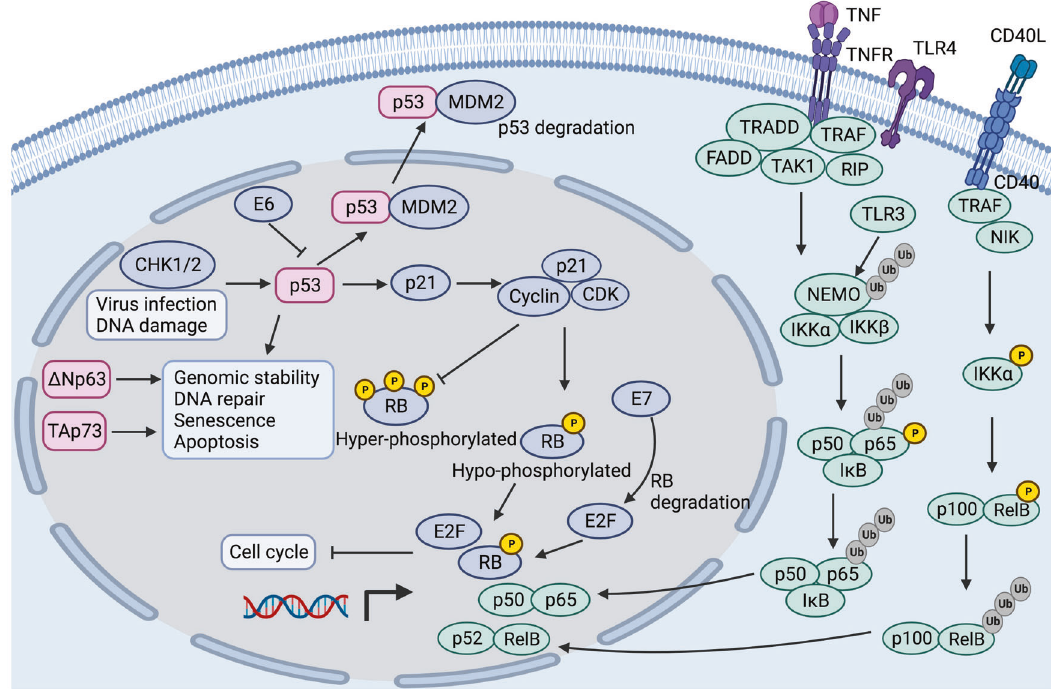
Fig. 3 The p53 signaling pathway and NF- κ B pathway in head and neck cancer. CHK1/2 cell cycle checkpoint kinase 1/2, MDM2 murine double minute 2, CDK cyclin-dependent kinase, RB retinoblastoma, TNF tumor necrosis factor, TNFR tumor necrosis factor receptor, TLR4 Toll- like receptor 4, TRAF TNFR-associated factor, RIP receptor-interacting protein, IKK I κ B